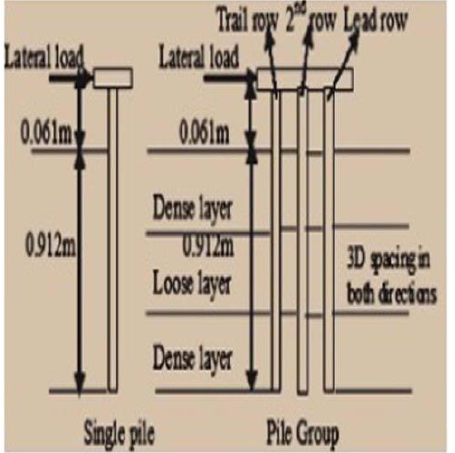
Fig. 1. Layouts of single and pile group